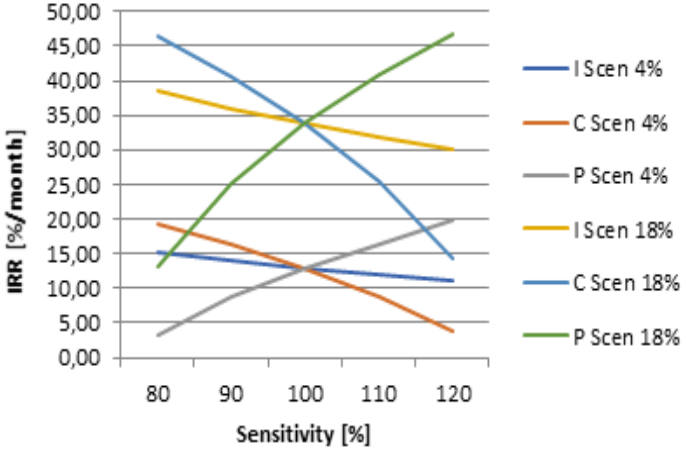
Figure 4: Graph of sensitivity I, C, R to PP in scenario 4% and